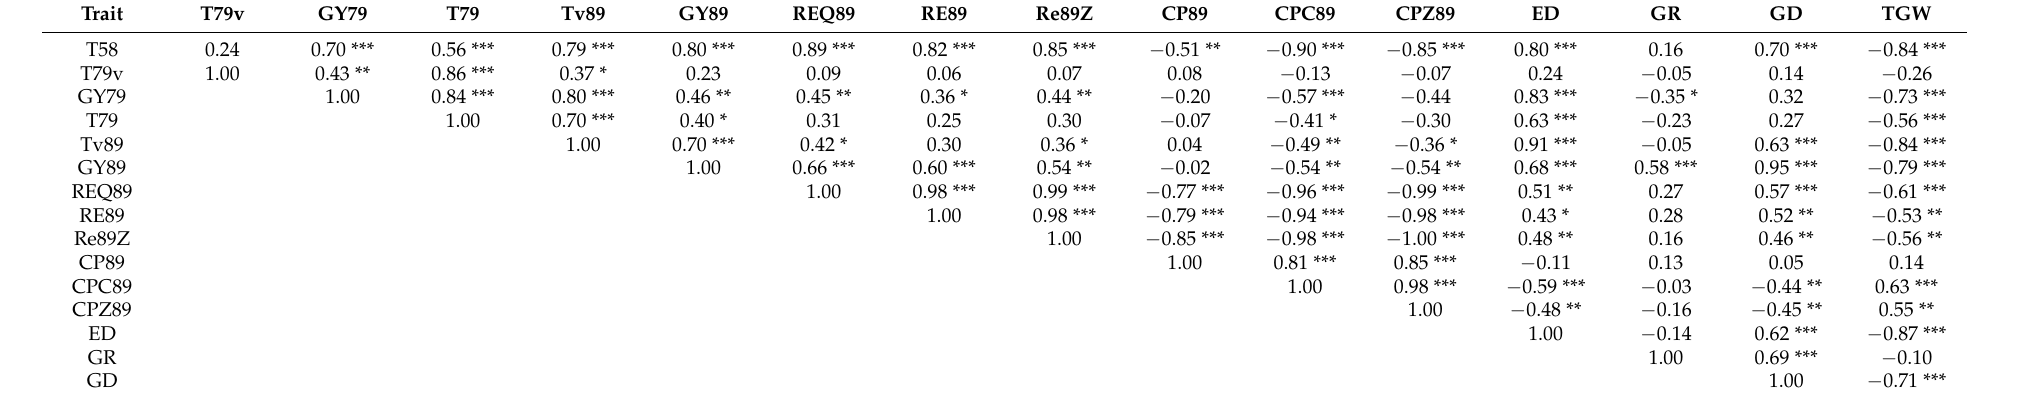
Table A2. Matrix of correlation indices for winter wheat remobilization indices during the grain-filling period, n =